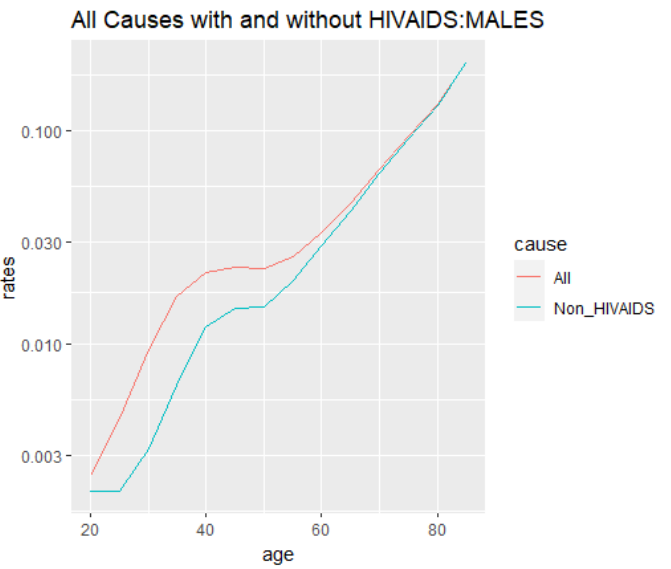
Figure 3. All causes and non-HIV/AIDS cause of death rates distribution for males against age.